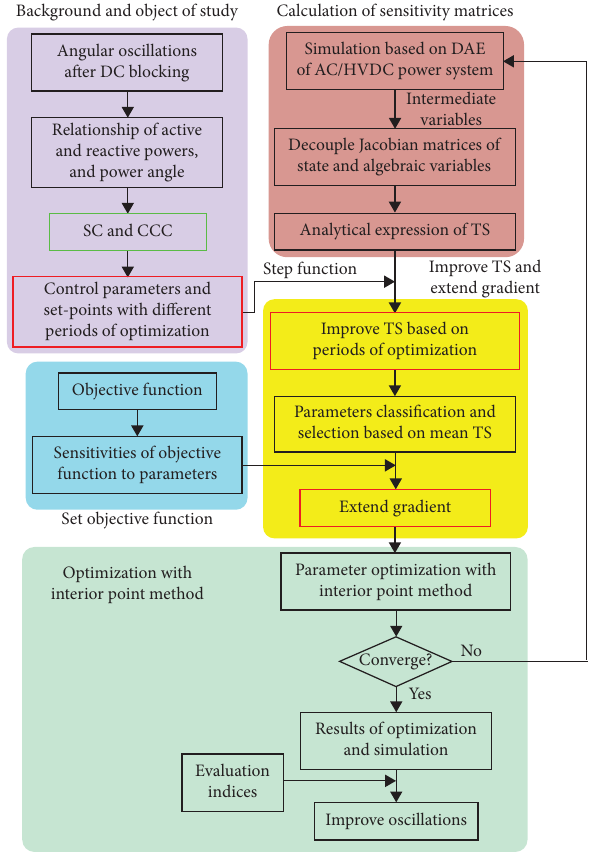
Figure 4: Multiparameter coordinated optimization diferentiating the period of